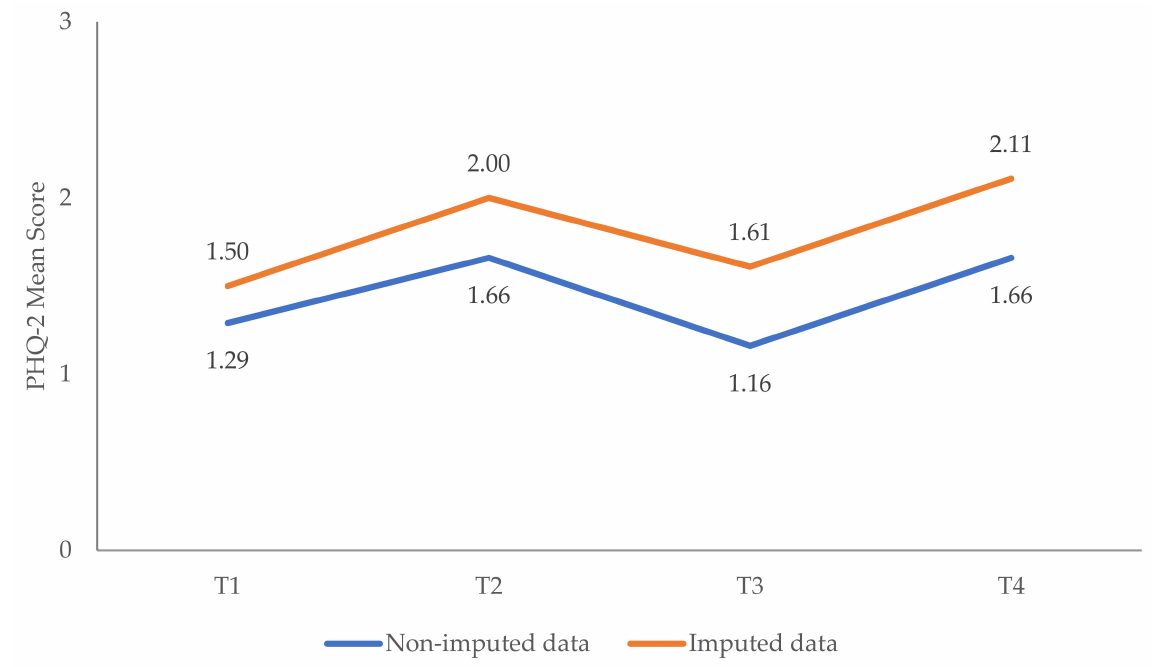
Figure A2. Changes in symptoms of depression (PHQ-2) over time: imputed vs. non-imputed results. Note: Imputed dataset: n = 1001. Non-imputed dataset: n = 220.